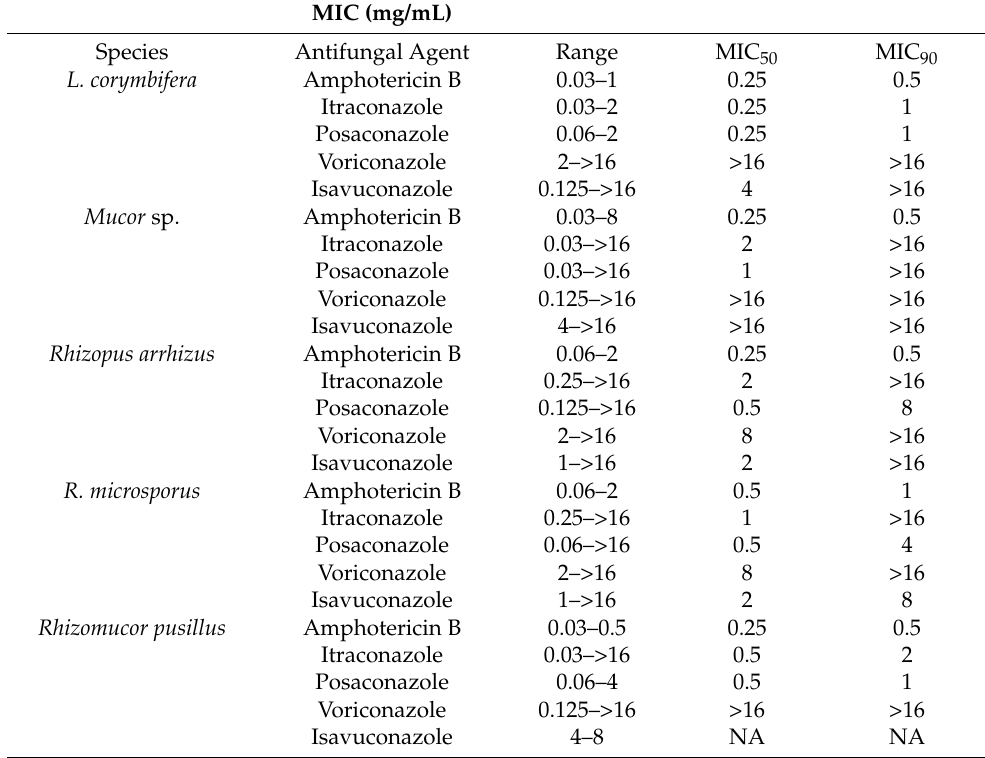
Table 6. Summary of MIC data for isolates of the Mucorales. NA—not appropriate due to the small number of isolates tested for this